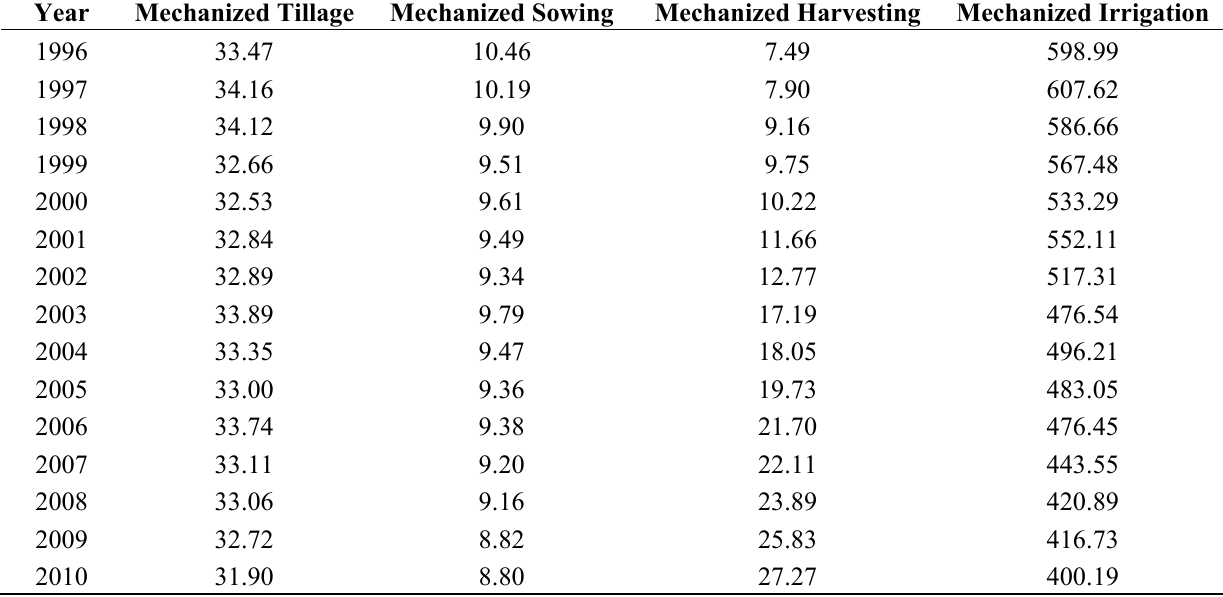
Table 6. Diesel consumption intensity (kg/ha) of the